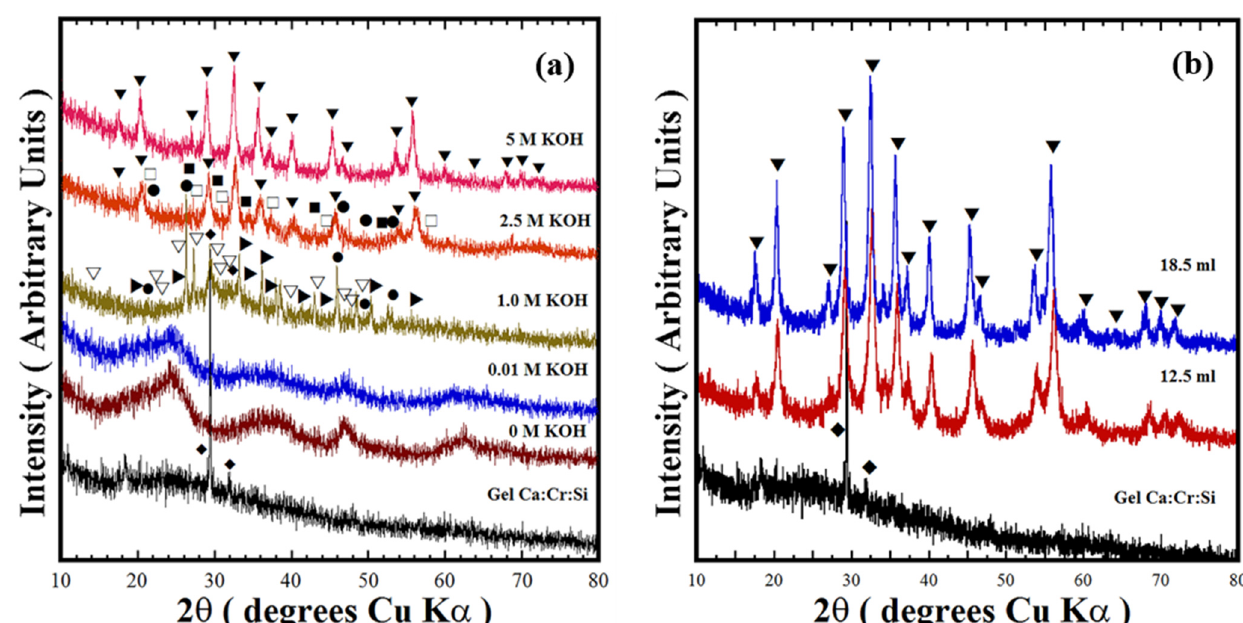
Figure 2. XRD patterns of the reaction products produced at 220 ◦ C for 24 h with different KOH solvent solution (18.5 mL) concentrations. The experiments were carried out with stoichiometrically mixed Si 4+ content of 3.0 mole ( a ). Those ( b ) of the powders prepared with two different volumes of the 5.0 M KOH solution; these experiments were all conducted at an autoclave stirring speed of 50 rpm. Indexed crystalline phases: ( (cid:72) ) Uvarovite structure Ca 3 Cr 2 Si 3 O 12 , COD card no. 96-900-7150, crystalline secondary phases: ( (cid:7) ) SiO 2 , ( • ) SiO 2 Quartz high COD card 96-101-1201, ( (cid:53) ) Ca 2 SiO 4 COD card no. 96-210-3317, ( ) CaCr 2 O 4 COD card no. 96-200-2211 phase, ( (cid:4) ) SiO 2 Coesite COD card no. 96-900-0805, ( (cid:3) ) Ca 2 SiO 5 COD card 96-200-1356.